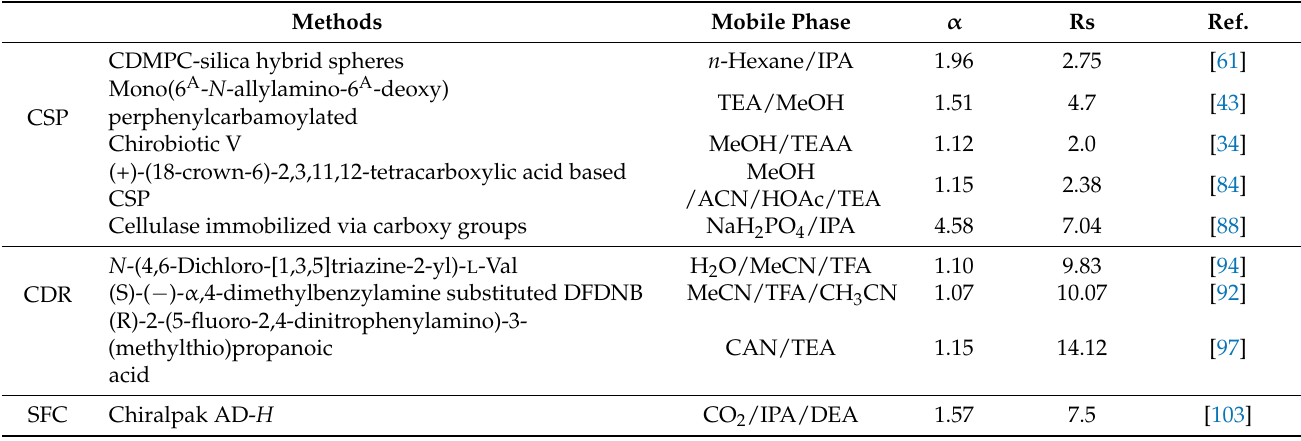
Table 13. Methods and typical results for the enantioseparation of propranolol.